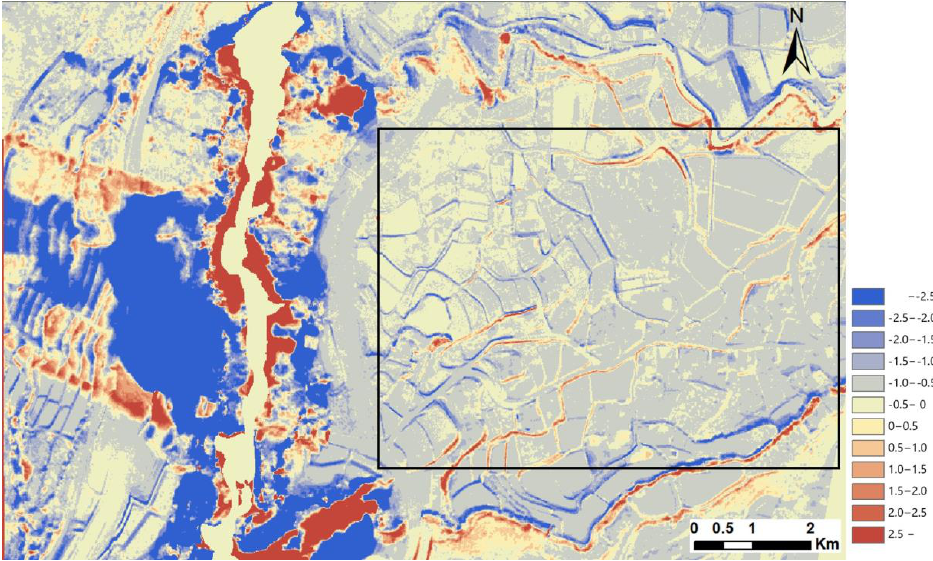
Figure 7. DTM difference in the co-event period (2013.1–2016.4) for Kawayo district. The average value within the black square was − 0.5